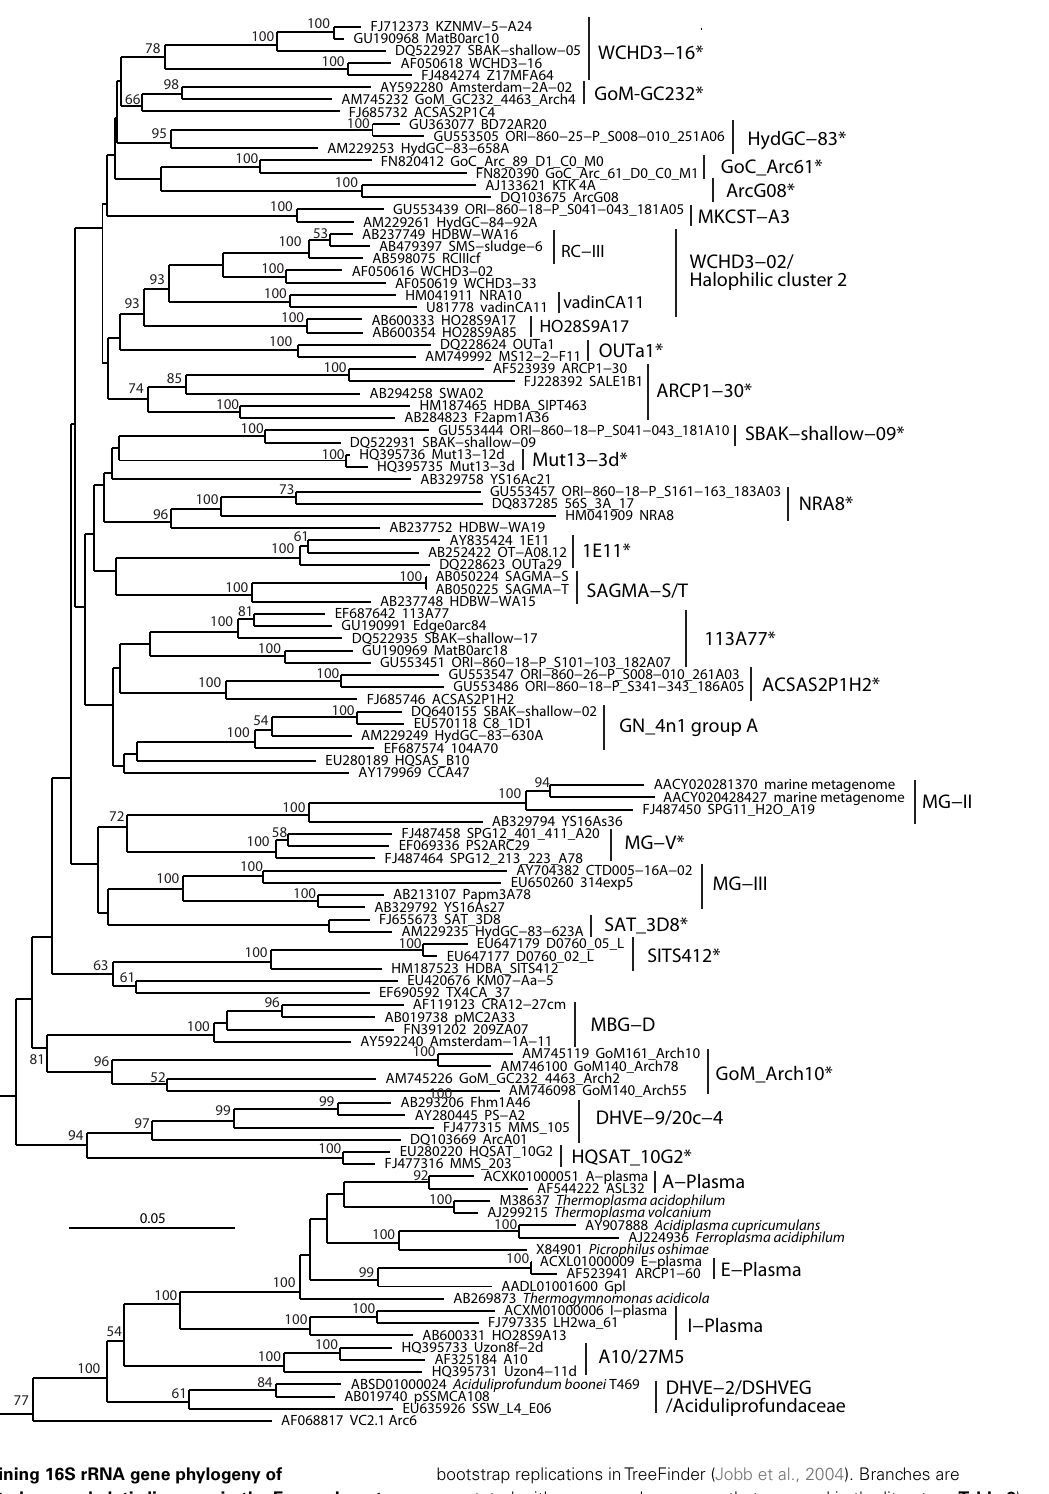
FIGURE 5 | Neighbor-joining 16S rRNA gene phylogeny of Thermoplasmata-affiliated monophyletic lineages in the Euryarchaeota. Alignment size, filtered using the arch_ssuref mask available in ARB, is 1145 sites. Statistical support was estimated using 500 maximum likelihood